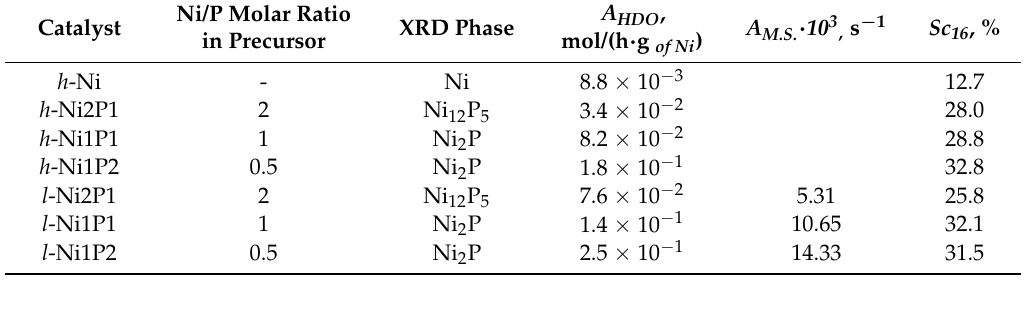
Table 2. Catalytic properties of silica-supported nickel and nickel phosphide catalysts in methyl palmitate HDO. Reaction conditions: P H2 = 3.0 MPa, T = 290 ◦ C, H 2 /feed = 600 Nm 3 /Nm 3 , LHSV = 1.5–16.0 h − 1 .